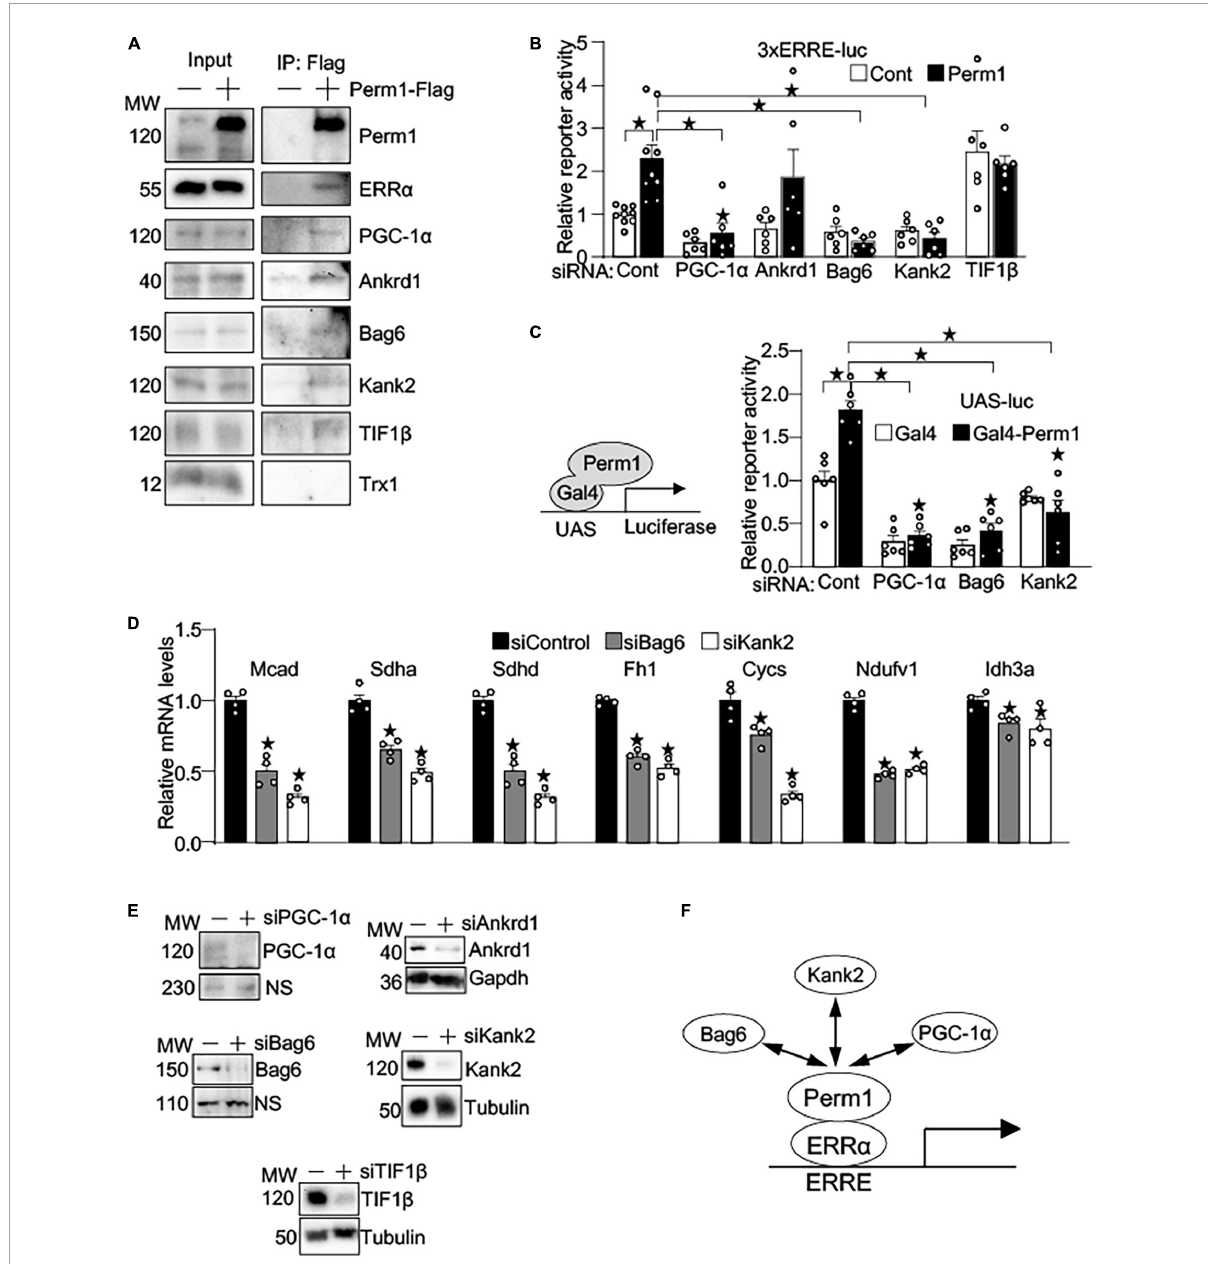
FIGURE7 PERM1 is a novel transcription coactivator that functionally interacts with PGC-1 α , BAG6, and KANK2. (A) Immunoprecipitation assays show that PERM1 binds to the transcriptional regulators ERR α , PGC-1 α , ANKRD1, BAG6, KANK2, and TIF1 β . Adenovirus Flag-tagged Perm1 (PERM1-Flag) was transduced to cardiomyocytes, and PERM1-bound proteins were pulled down by anti-Flag antibody. Immunoblotting confirmed the interaction of PERM1 with ERR α , PGC-1 α , ANKRD1, BAG6, KANK2, and TIF1 β . In contrast, TRX1, which was also identified through MS-based screening as a potential binding partner in transcription regulation, did not bind to PERM1. (B) Luciferase reporter gene assays show that the PERM1-induced transcriptional activation of the ERRE requires PGC-1 α , BAG6, and KANK2 ( n = 7-9/group). Cardiomyocytes were transduced with 3xERRE-luc, followed by transfecting with either scrambled-siRNA (scr), siPGC-1 α , siANKRD1, siBAG6, siKANK2, or TIF1 β . (C) In vitro Gal4 assay shows the recruitment of PERM1 to a gene promoter induces transcriptional activation ( n = 6/group). Gal4-fused Perm1 (Gal4- Perm1 ) was expressed with UAS-luc, a reporter gene driven by Gal4 binding sequence, in cardiomyocytes. In control (scrambled-siRNA, “scr”), the reporter activity was significantly increased by Gal4- Perm1 , indicating that PERM1 can act as a transcription coactivator. Silencing of PGC-1 α , BAG6, KANK2 inhibited the transcription activation by PERM1. (D) qPCR shows downregulation of ERR target genes by silencing BAG6 and KANK2 (siBag6 and siKank2) in cultured cardiomyocytes ( n = 4/group). (E) siRNA-mediated knockdown of PGC-1 α , ANKRD1, BAG6, KANK2, or TIF1 β were verified by western blotting analyses. (F) Hypothetical model of transcriptional regulation by PERM1 on the ERRE. PERM1 is localized to and activates the ERRE in ERR target genes through interacting with ERR α and the other transcriptional regulators BAG6, KANK2, and PGC-1 α (* p <